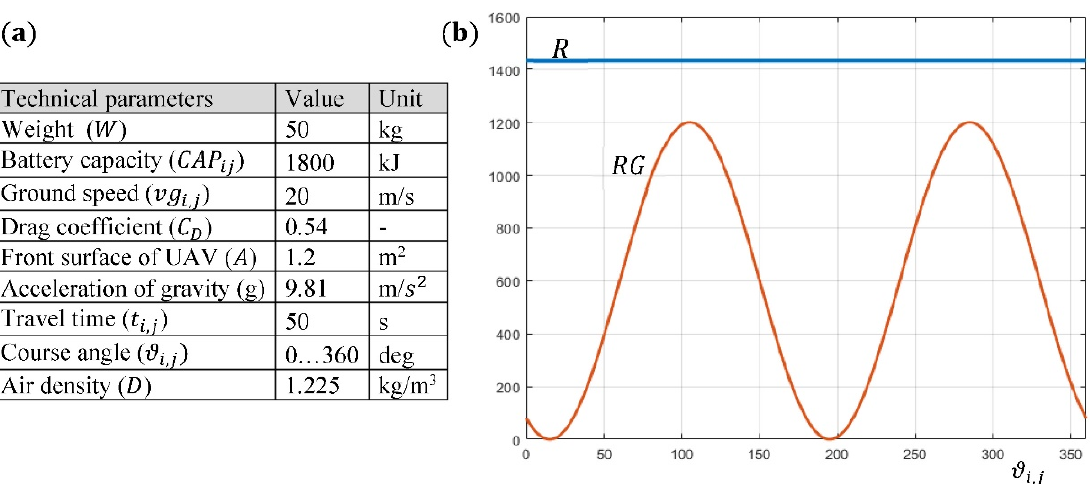
Figure 6. Examples of UAVs technical parameters (a) and their corresponding values 𝑅 and 𝑅𝐺 (b).